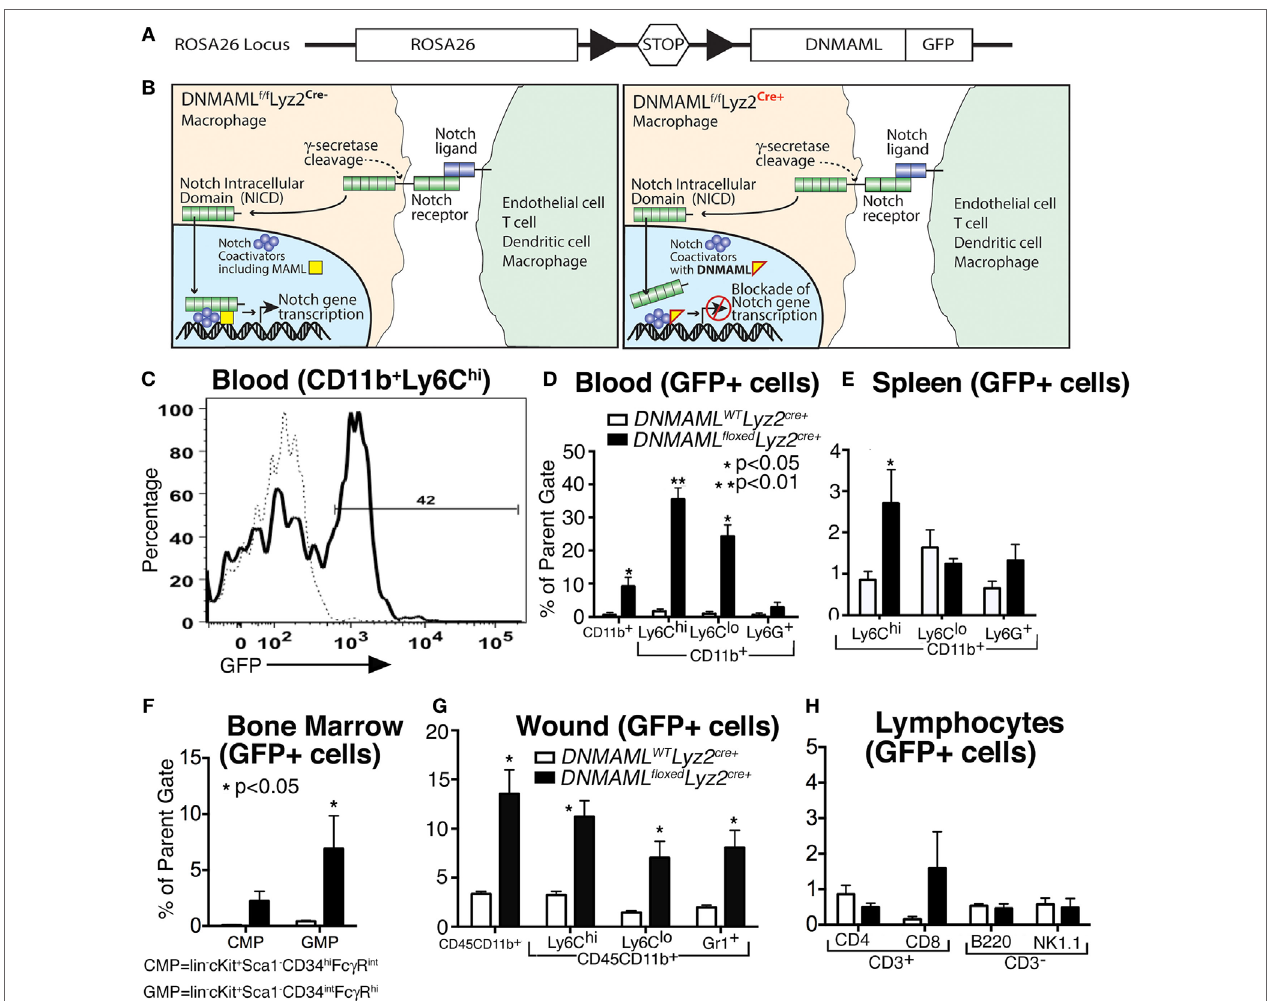
FigUre 2 | generation of a macrophage-specific, notch signaling-deficient murine model ( DNMAML floxed Lyz2 Cre + ) with myeloid specificity in tissues . (a) Gene construct representing DNMAML floxed mice on a C57Bl/6 background, where crossing mice with C57Bl/6-Lyz2 Cre + will result in excision of a stop codon and transcription of DNMAML-GFP from the Rosa26 Locus in macrophages. (B) Schematic demonstrating blockade of downstream Notch signaling following receptor/ ligand interaction in DNMAML floxed Lyz2 Cre + mice. (c) Representative example of flow cytometry for green fluorescent protein (GFP) in CD11b + Ly6C hi cells isolated from peripheral blood in the DNMAML floxed Lyz2 Cre + mice. (D–g) Percentage of GFP + cells in myeloid cell populations examined by flow cytometry from DNMAML floxed Lyz2 Cre + mice and littermate controls in (D) peripheral blood, (e) spleen, (F) bone marrow, and (g) peripheral wounds ( n = 5 mice/group, replicated 2 × ) (* P < 0.05;** P < 0.01). (h) Percentage of GFP + cells in lymphocyte populations from spleen examined by flow cytometry from DNMAML floxed Lyz2 Cre + mice and littermate controls ( n = 5 mice/group, replicated 2 × ). All data are expressed as mean ±